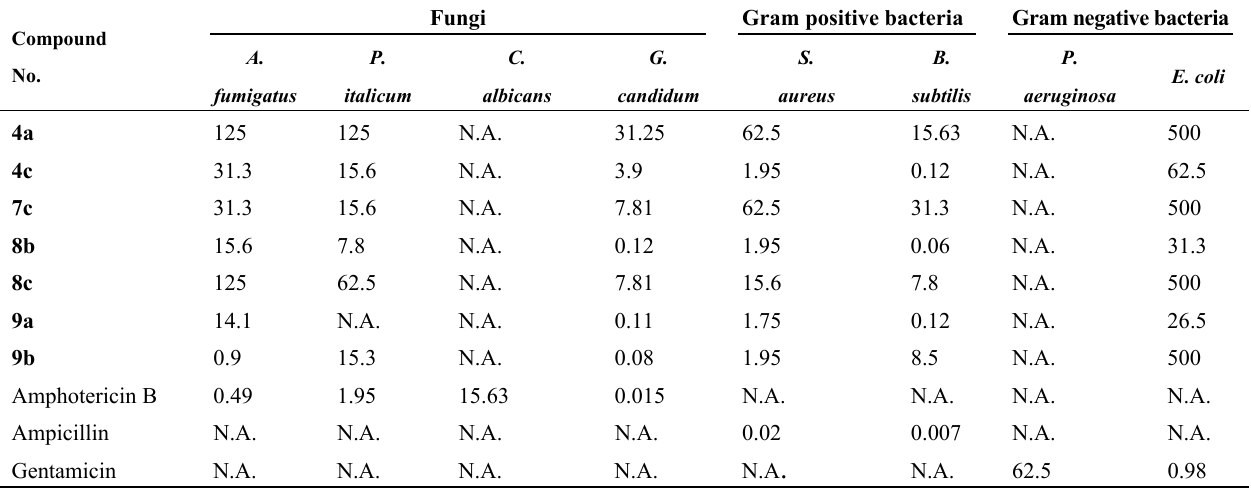
Table 2. Minimum inhibitory concentration (µg/mL) against the pathological